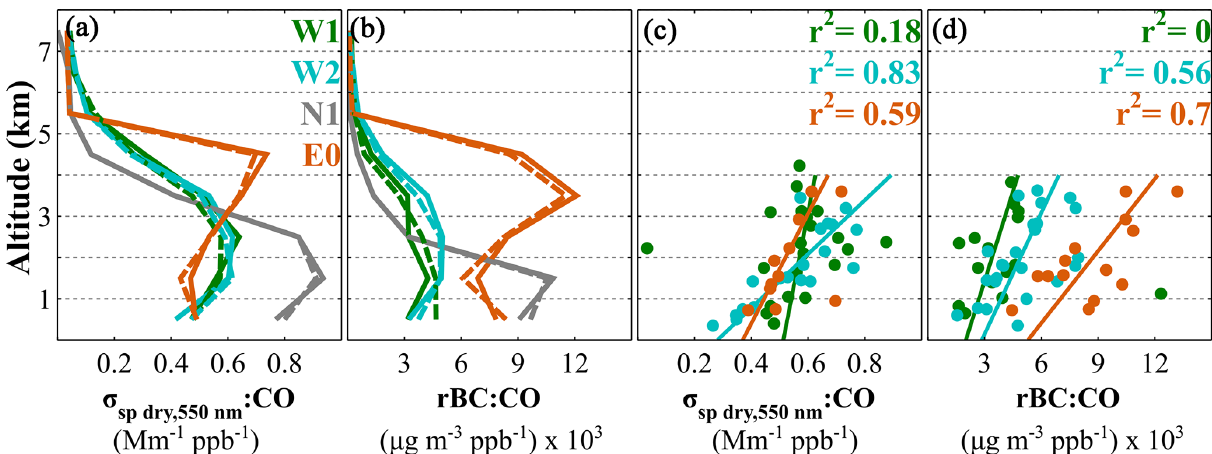
Figure 9. Median enhancement profiles of σ sp_dry : CO (a) and rBC : CO (b) for each regime. Solid (dashed) line represents averages with (without) plumes included. The enhancements were calculated for each individual profile by subtracting the regime 5th percentile. Plume enhancement ratios of σ sp_dry : CO (c) and rBC : CO (d) calculated from plume-integrated values above the local background (moving 5th percentile, i.e. dashed grey baseline in Fig. 3) only when the two pollutants are well correlated (Pearson’s r > 0 . 5). Ratios reported for pollutants are at ambient temperature and pressure.